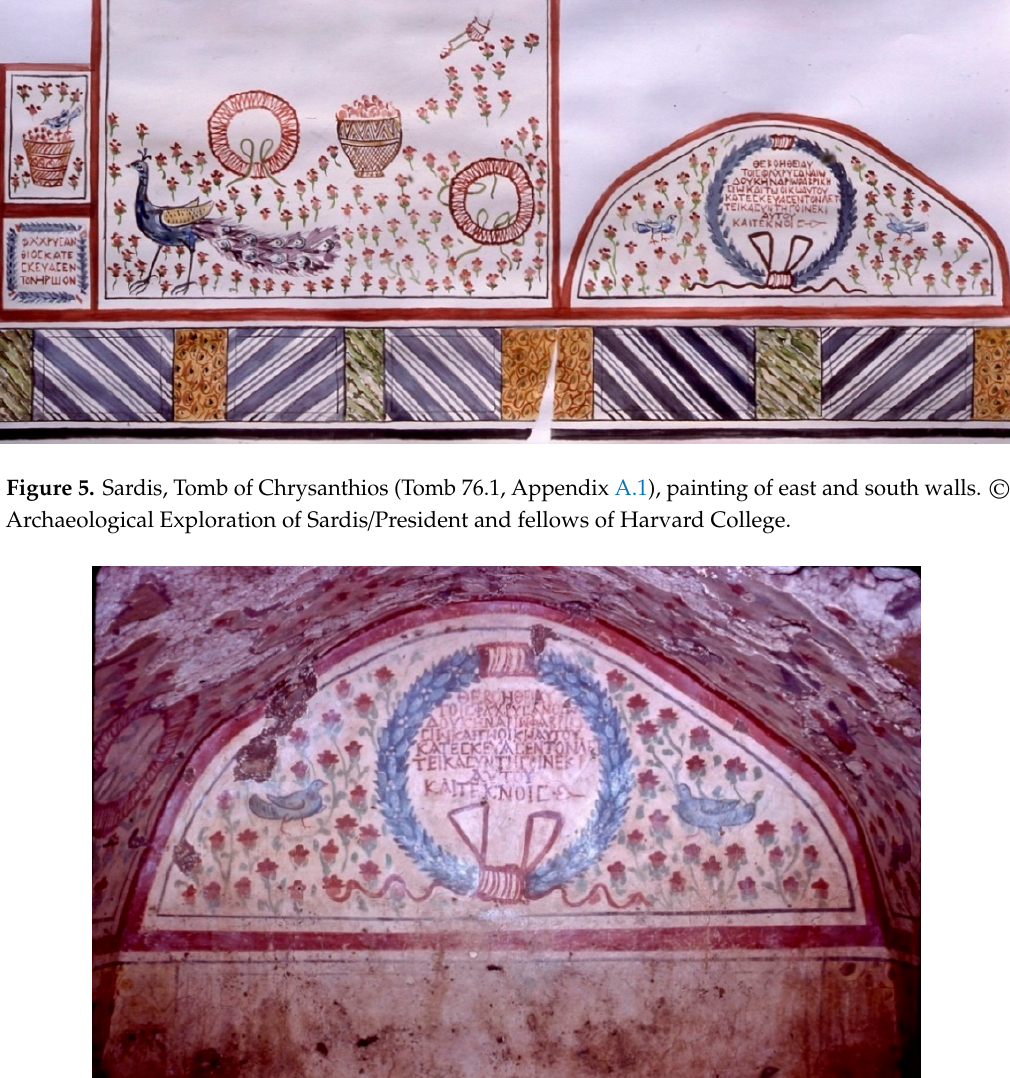
Figure 7. Sardis, Tomb of Chrysanthios (Tomb 76.1, Appendix A.1), east wall. © Archaeological Exploration of Sardis/President and fellows of Harvard College.